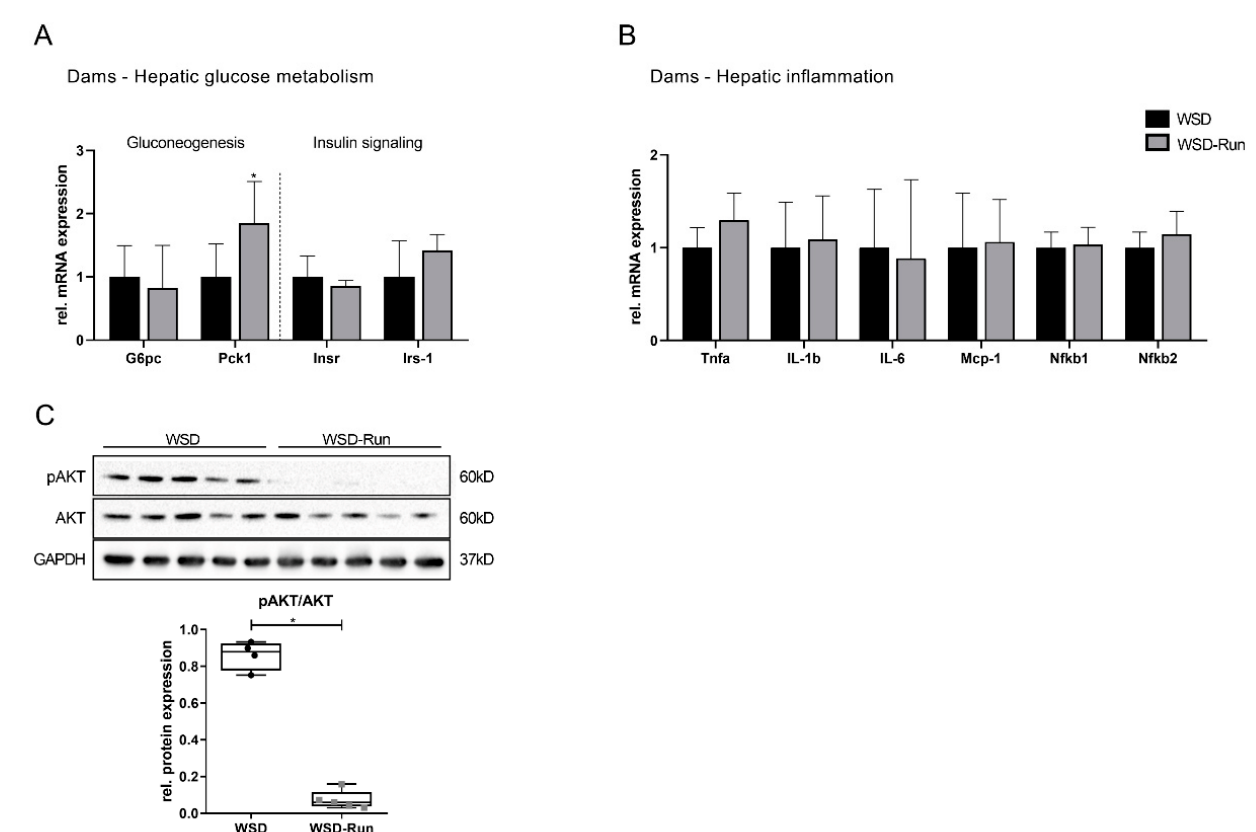
Figure 3. Impact of maternal exercise on markers of hepatic glucose metabolism and inflammation. ( A ) Assessment of regulators of hepatic gluconeogenesis ( G6pc , Pck1 ) and hepatocellular insulin signalling ( Insr , Irs-1 ) by qPCR (WSD group (n = 5), WSD-Run (n = 10)). ( B ) Determination of regulators of hepatic inflammation ( Tnfa , Il-1b , Il-6 , Mcp-1 , Nfkb1 , Nfkb2 ) by qPCR (WSD group (n = 5), WSD-Run (n = 10)). ( C ) Representative immunoblot of phosphorylated (p)AKT, as marker of hepatic insulin signalling (WSD group (n = 5), WSD-Run group (n = 5)). GAPDH served as loading control. Data are presented as mean ± standard deviation; * p < 0.05. AKT, protein kinase B; GAPDH, glyceraldehyde 3-phosphate dehydrogenase; G6pc, glucose-6-phosphatase; Insr, insulin receptor; Irs-1, insulin receptor substrate-1; Il-1b, interleukin-1b; Il-6, interleukin-6; Mcp-1, monocyte chemoattractant protein-1; Nfkb, nuclear factor kappaB; Pck1, phosphoenolpyruvate carboxykinase; Tnfa, tumor necrosis factor-alpha.